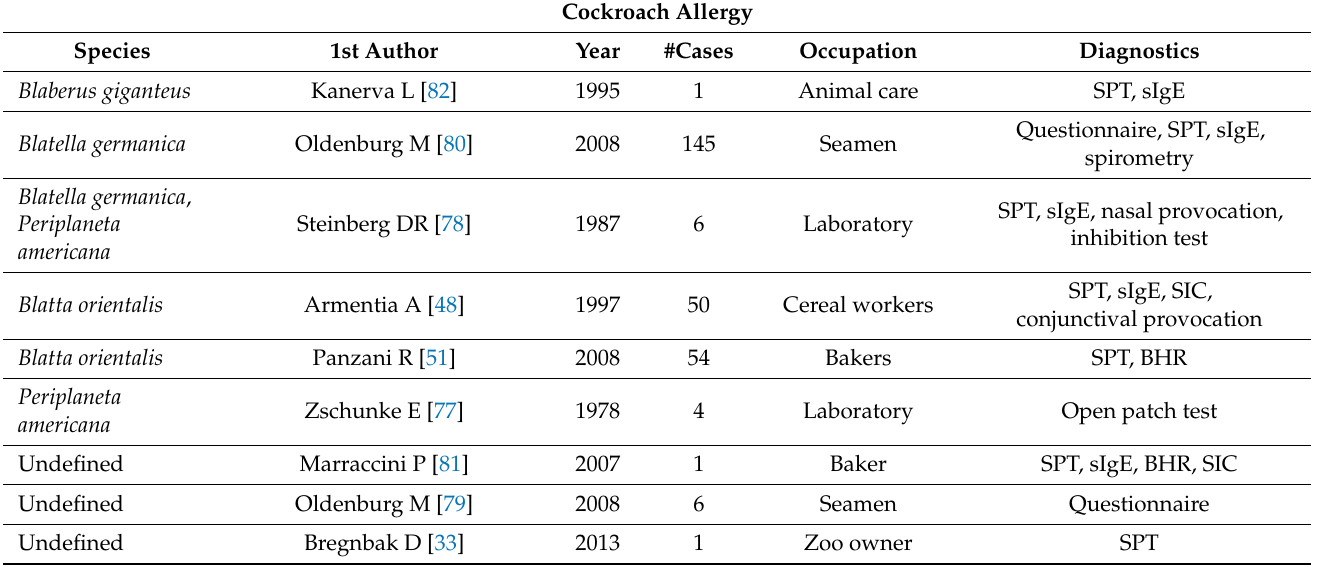
Table 4. Blattodea